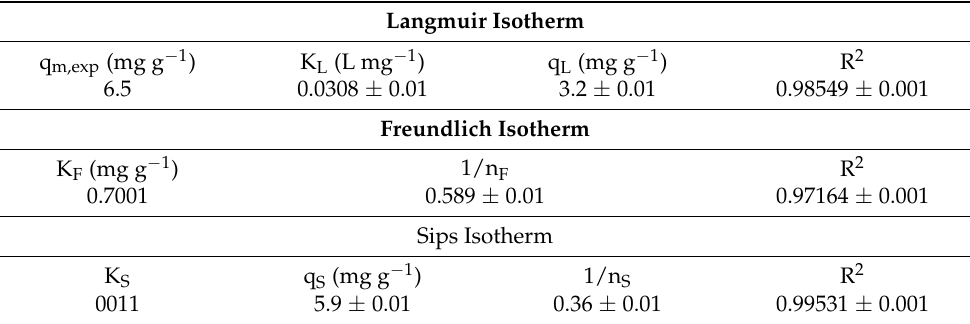
Table 3. Comparison to other materials for Pd(II) adsorption.